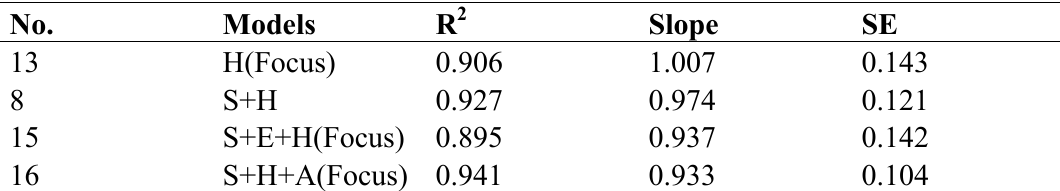
Table 3. Correlation coefficient between predicted and experimental PLogIC50 of the test set by model 13 , 8 , 15 , and 16 .